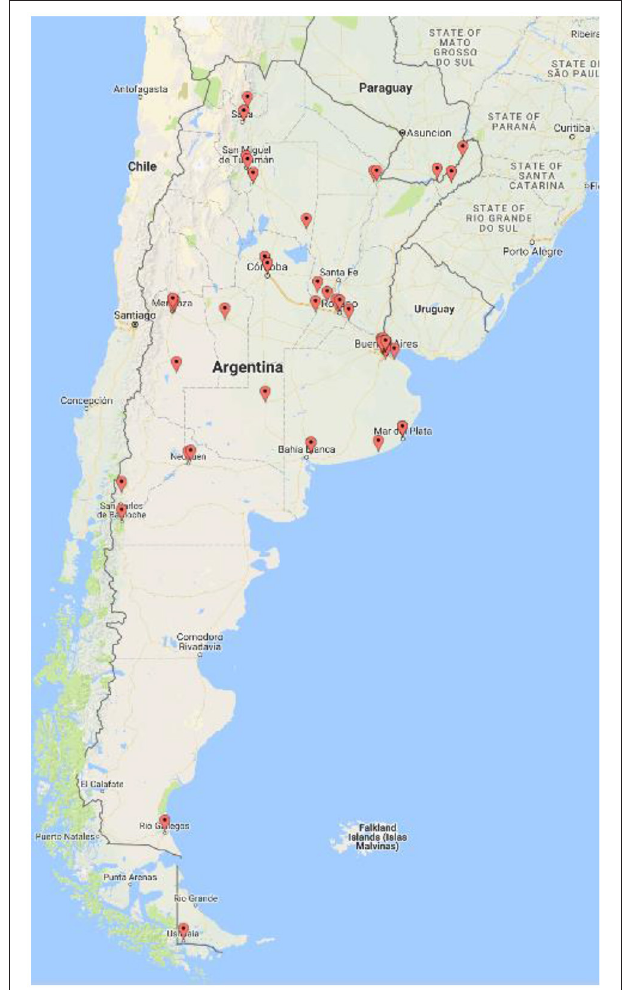
FIGURE 1 | Map representation of participating